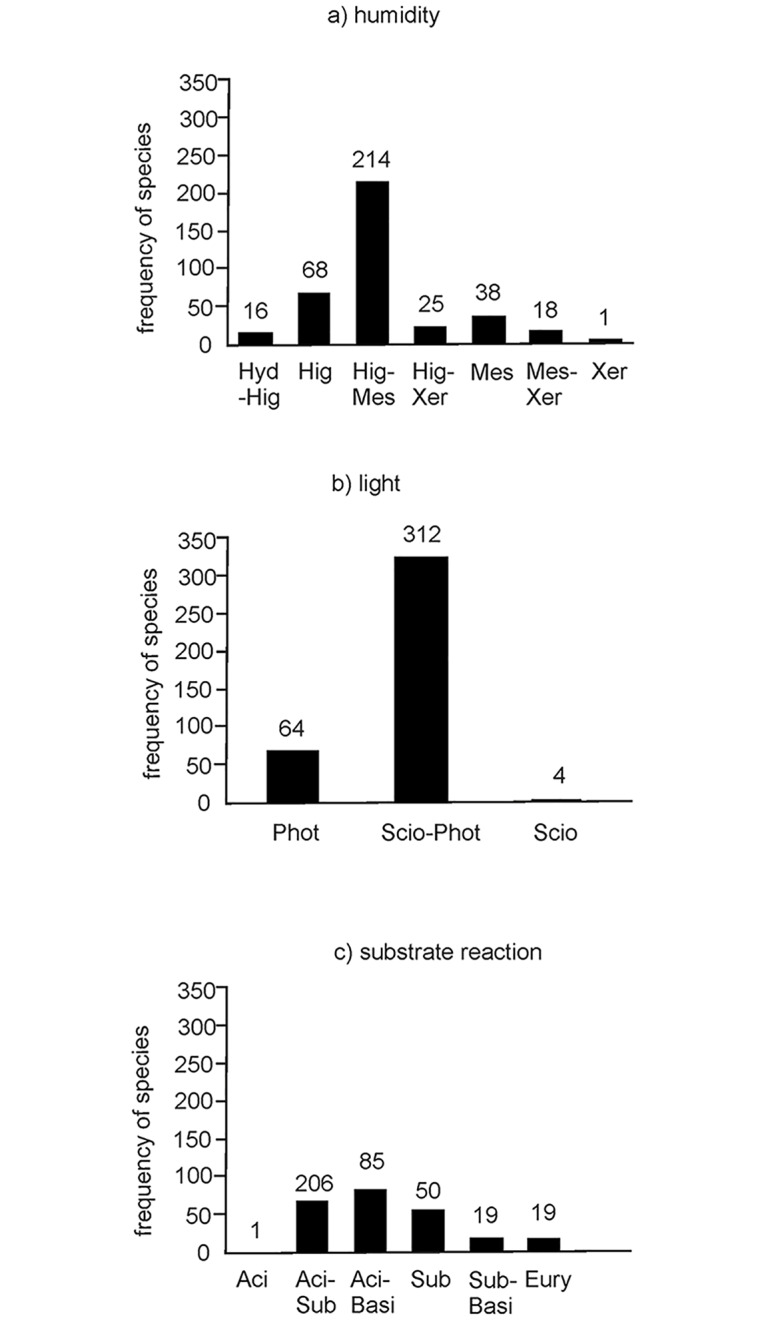
General ecological requirements of the bryophyte species found in the researched meadows.(a) Humidity: Hyd—hydrophyte, Hig—hygrophyte, Mes—mesophyt, Xer—xerophyte, Hyd-Hig, Hig-Mes, Hig-Xer, Mes-Xer—contain species with a wide range with regard to humidity, put into two or more groups by Dierßen (2001). (b) Light: Scio—sciophyt, Phot—photophyt, Scio-Phot—large ecological amplitude, growing in both shade and full light. (c) Substrate reaction: Aci—acidophyt, Sub—subneutrophyt, Basi—basiphyt), Aci-Basi, Aci-Sub, Sub-Basi, Eury—species tolerant of a wide range of pH-value, which are listed in two or more categories by Dierßen [65].